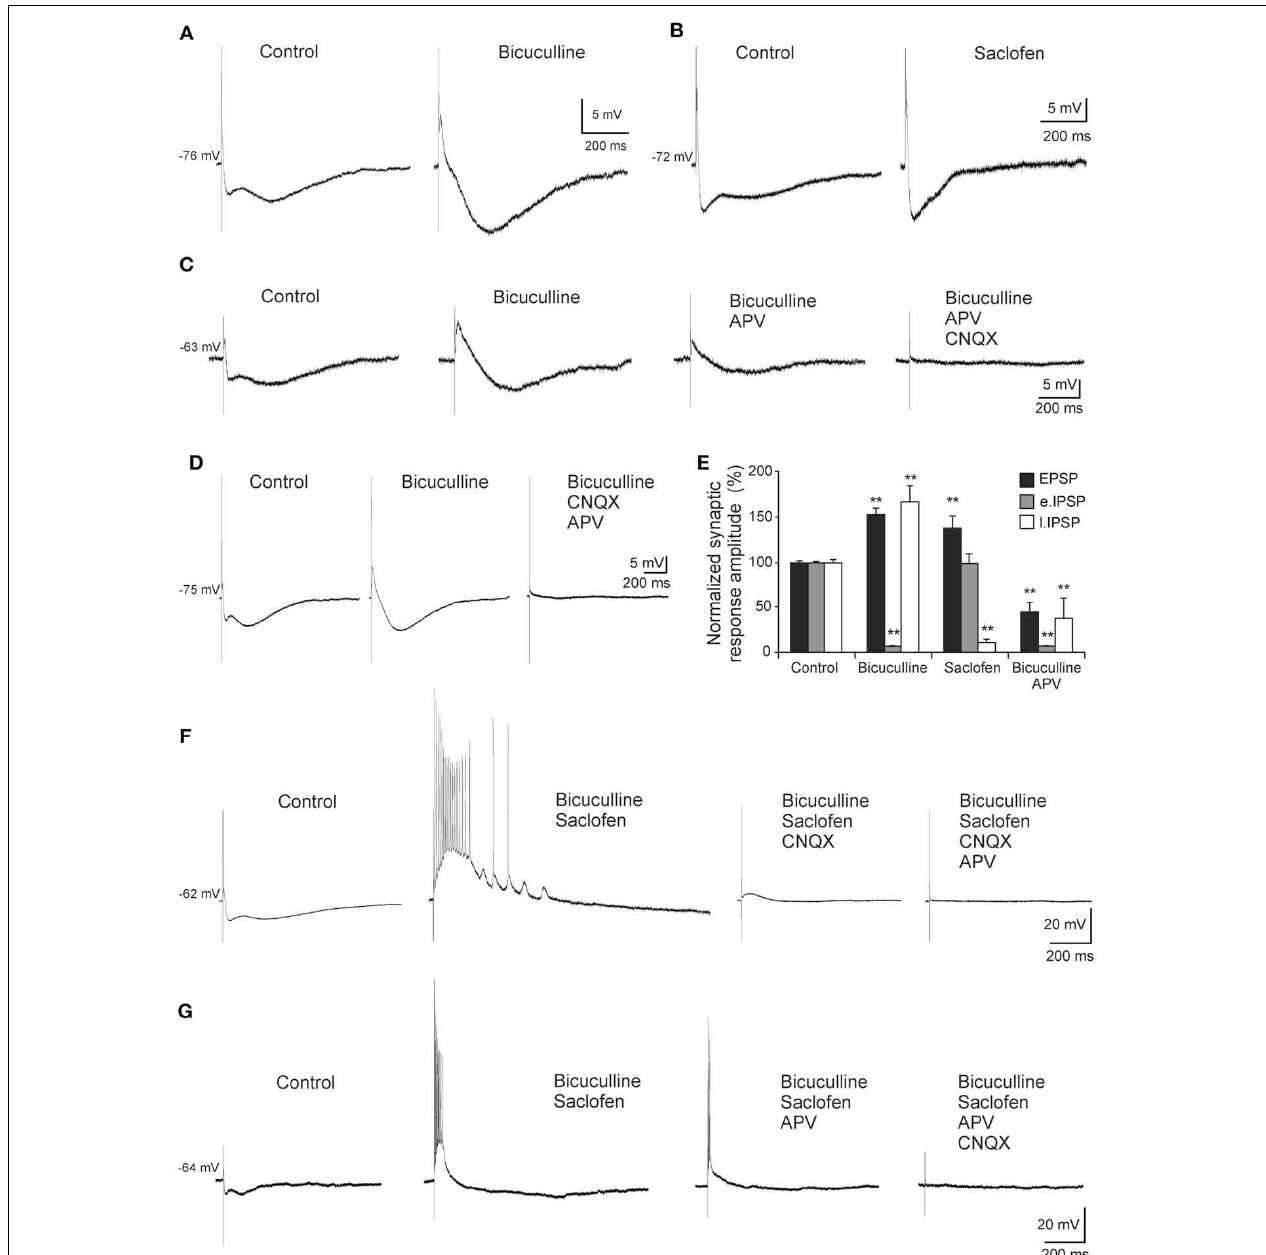
FIGURE 3 | Pharmacological characterization of septohippocampal synaptic response. (A) Recordings from a pyramidal CA3 neuron illustrating a marked reduction of the early IPSP after perfusion with bicuculline (10 μ M; specific blocker of GABA A receptors). (B) Blocking of the late IPSP after perfusion with saclofen (200 μ M; blocker of GABA B receptor) was accompanied by a mild increase of the early IPSP and EPSP. (C) The increase in the amplitude of EPSP and late IPSP produced by perfusion of bicuculline was reduced by APV application (50 μ M; specific blocker of NMDA receptor). Membrane potential was maintained at values more positives than resting membrane potential to assure NMDA receptors functionality. Synaptic response was completely removed with the addition of CNQX (10 μ M; competitive non-NMDA receptor antagonist). (D) Blockade of the early IPSP with bicuculline ( n = 4) was associated with a marked increase in amplitude of EPSP and late IPSP. Excitatory and